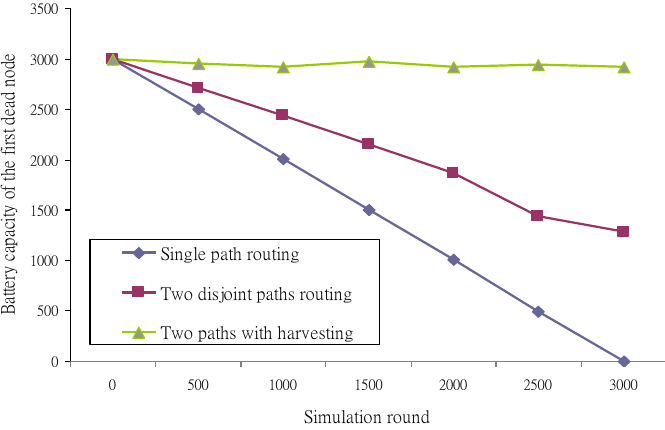
Figure 14. Network lifetime of two disjoint paths routing for rechargeable wireless sensor networks (WSNs).